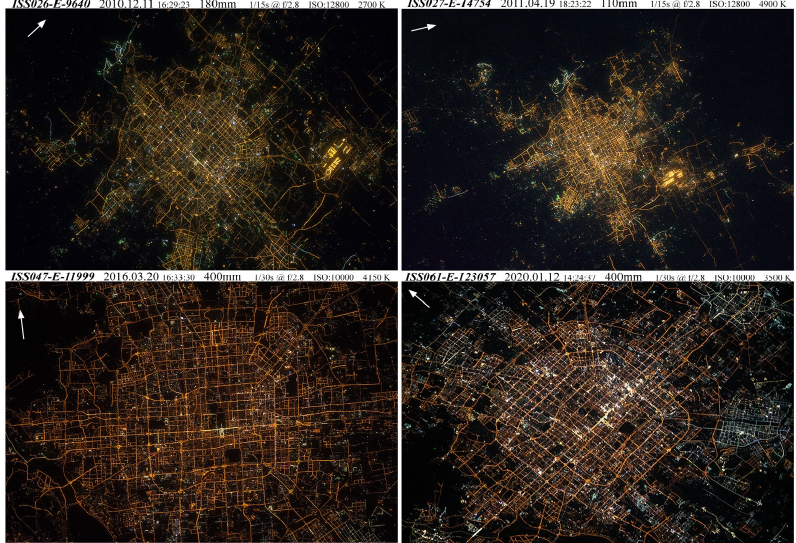
Figure 1. Urban lightscape comparison of Beijing photographed at different dates, local times, view geometries, focal lengths, exposures and white balance settings. The 2010 and 2011 shots ( top ) were taken with the same camera (Nikon D3S) less than 4 months apart and differ primarily in lens focal length (hence, spatial resolution) and white balance temperature. The 2016 and 2020 shots ( bottom ) were taken with different cameras (Nikon D4 & D5) using the same lens, exposure and ISO and similar white balance temperature, but different local times and view geometries. The greater number and brightness of white lights within the four inner ring roads in the 2020 shot may be a combined result of the earlier local time and more oblique view geometry imaging, as well as more illuminated facades and commercial lighting not seen in the near-nadir view shot taken after midnight, local time. Arrows in UL corners show north. Technologies 2022 , 10 , x FOR PEER REVIEW